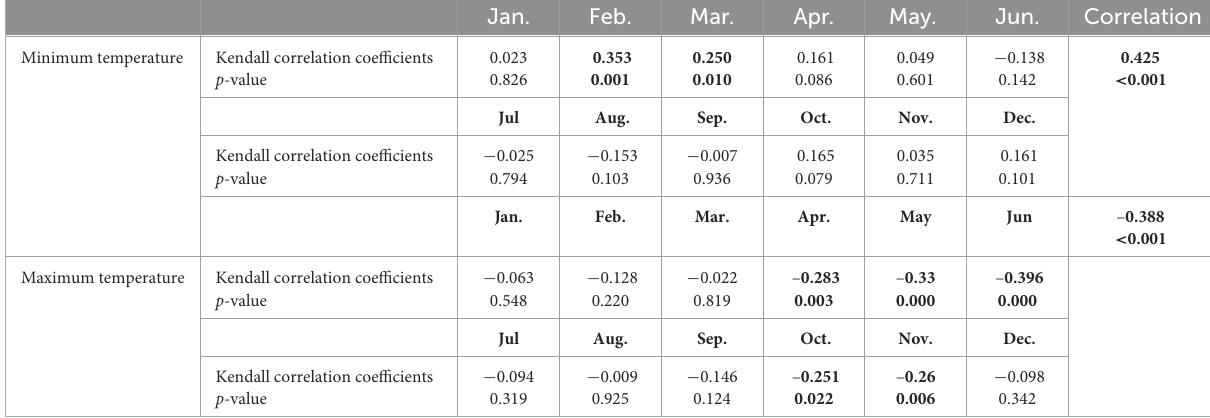
TABLE 5 Correlation analysis for monthly minimum and maximum temperature with rainfall from 1961 to 2015.